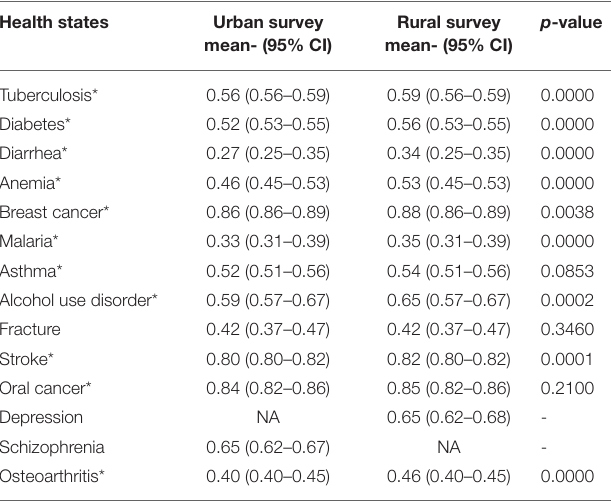
TABLE 3B | Mean disability weights for different health states across Location (urban/rural).